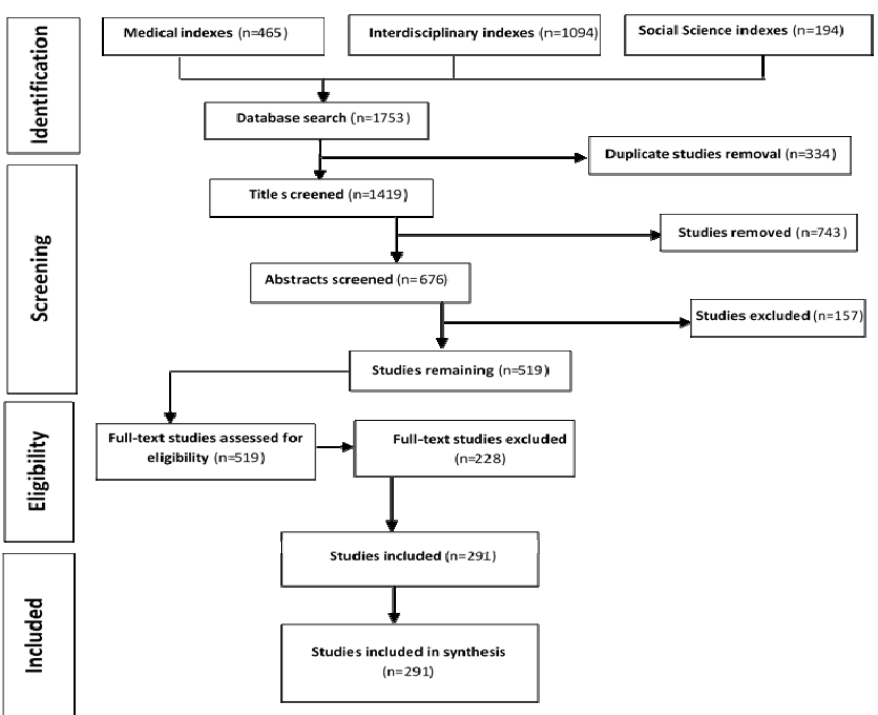
Figure 1. Review process of the search results by search database guided by PRISMA. Medical indexes: PubMed, CINAHL. Interdisciplinary indexes: Scopus, Web of science. Social science indexes: ERIC, JSTOR, and PsychINFO.